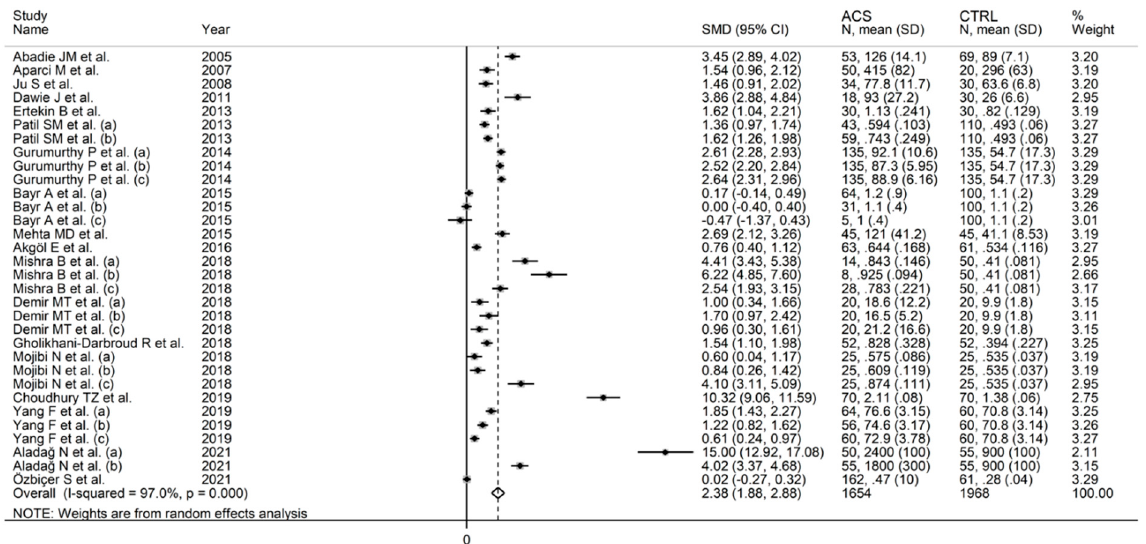
Figure 2. Forest plot of studies examining ischaemia-modified albumin in patients with acute coronary syndrome and controls.